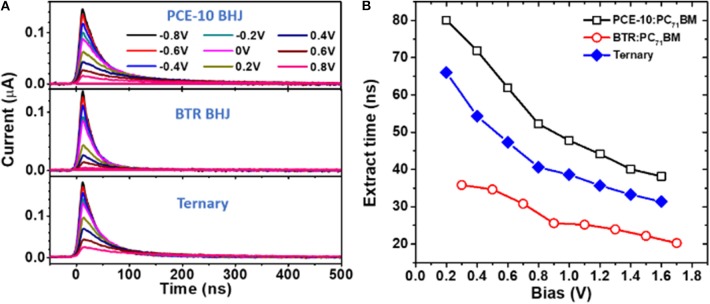
(A) Transient photocurrent (TPC) decay kinetics of different BHJ-OSCs measured with applying different biases (excitation at 488 nm). (B) Extraction time of charges in operating solar cells as a function of bias determined by fittings with a mono-exponential decay model.